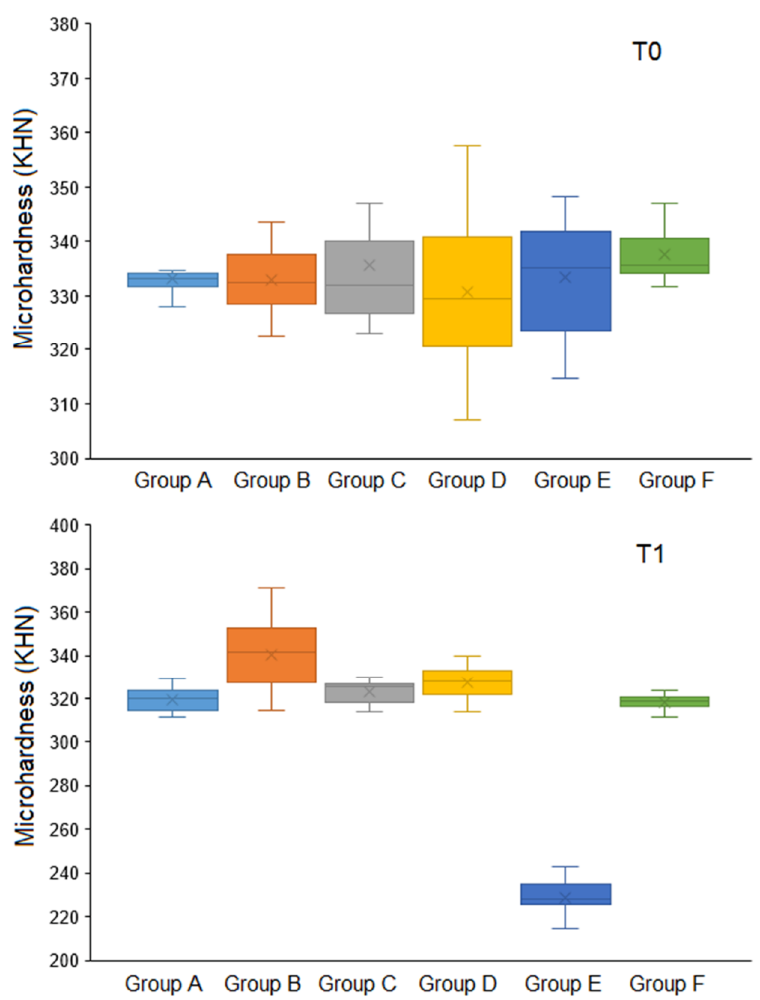
Figure 2. Box plots of Knoop hardness (KHN) of the study groups at different measurement inter- vals. Group A—Opalescence™ PF; Group B—distilled water; Group C—iWhite Dark Stains Tooth- paste; Group D—24 K white charcoal teeth-whitening pen; Group E—0.25% Citric.